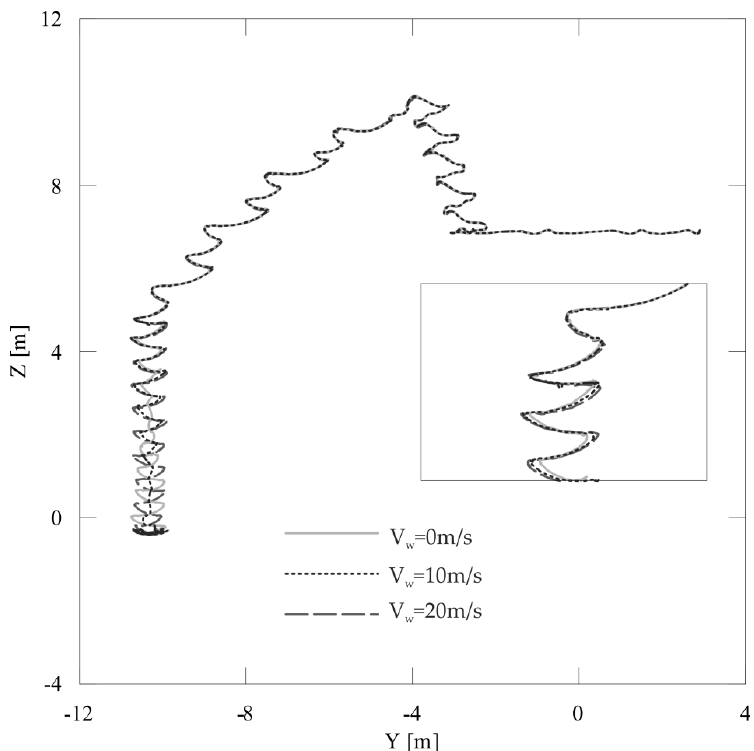
Figure 21. Trajectory projections of the carried load’s center of mass in one of the lifting planes (wind power having impact according to the direction of the X axis).